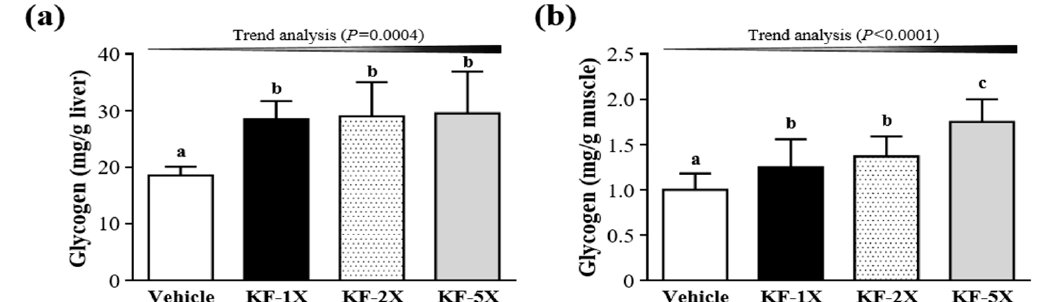
Figure 5. Effects of kefir (KF) supplementation on ( a ) liver glycogen and ( b ) muscular glycogen. Data are presented as mean ± SD, n = 8. Bars with different letters ( a , b , c ) indicate a significant difference at p < 0.05 determined using one-way ANOVA. Vehicle (glucose water), KF-1X (2.15 g/kg/day KF), KF- 2X (4.31 g/kg/day KF), and KF-5X (10.76 g/kg/day